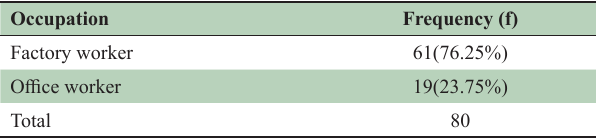
Table-III: Distribution of respondents according to their job